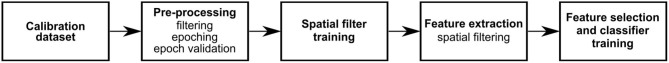
Processing stages for system calibration. The information contained in a calibration dataset is pre-processed and analyzed to obtain a set of spatial filters and a classification model. These two components are necessary to operate the BMI and control the hand-orthosis.